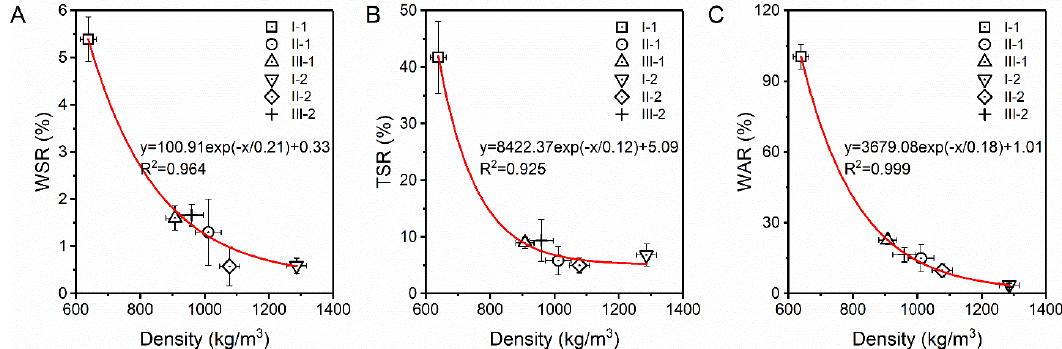
Figure 7. Water resistance of the LC samples: ( A ) WSR, ( B ) TSR, and ( C ) WAR.